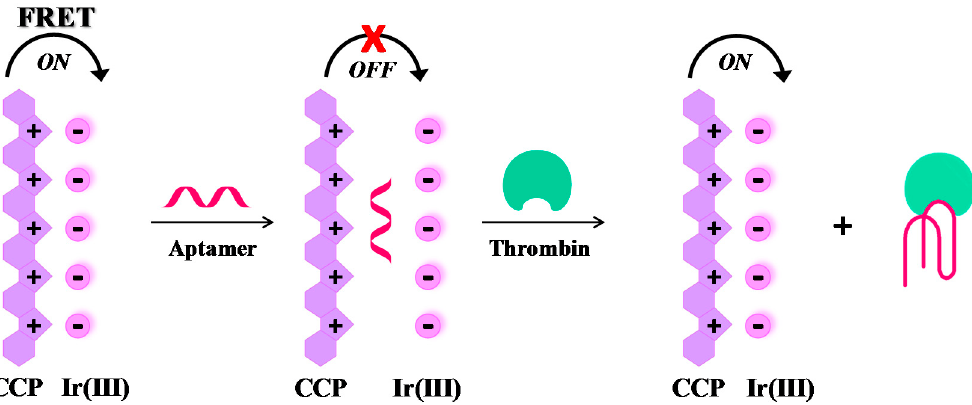
Figure 6. Schematic representation of a label-free, “signal-on” sensing strategy for the selective detection of thrombin, as described in reference [97].